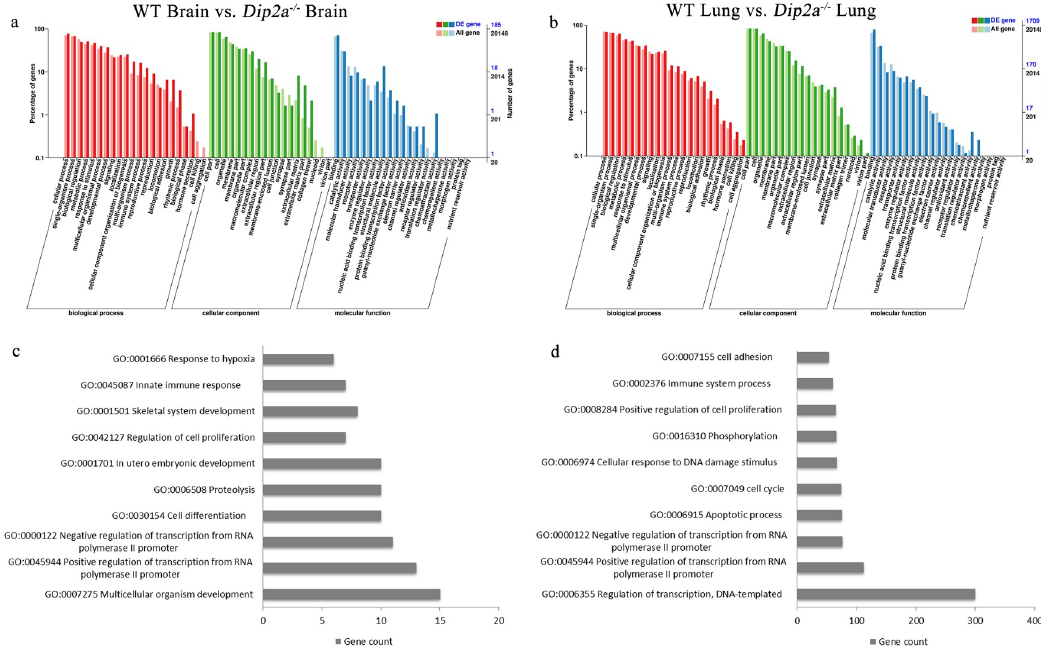
Fig 3. Gene Ontology (GO) classification of DEGs from WT brain vs. Dip2a -/- brain (a, c) and WT lung vs. Dip2a -/- lung (b, d). (a,b) Histogram of GO annotation was generated by KOBAS (kobas.cbi.pku.edu.cn). The X-axis indicates GO classification, the Y- axis on the left indicates the percentage of genes, and the Y-axis on right indicates the number of genes. One gene could be assigned with more than one GO term. (c,d) Most significant enriched biological terms in brain and lung.